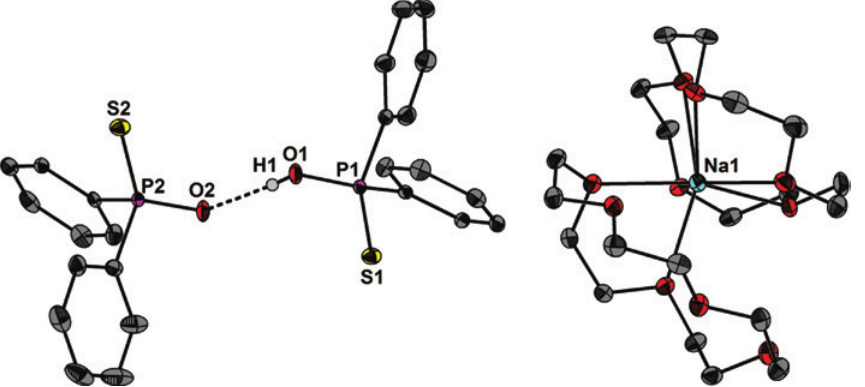
Figure 2: Molecular structure of 2 showing 50% probability ellipsoids and the crystallographic numbering scheme. Selected bond parameters of 2 [Å, ° ]: P1–O1 1.543(2), P1–S1 1.957(1), P2–O2 1.532(2), P2–S2 1.960(1), O1–O2 2.434(2), O1–P1–S1 118.5(1), O2–P2–S2 119.2(2).Scheme 1 Syntheses of [Na(15-crown-5)][Ph